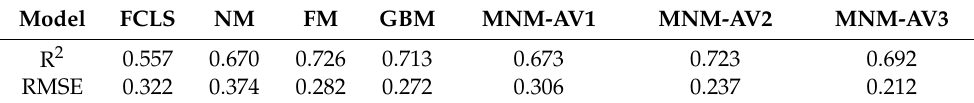
Table 4. Assessment of lichens abundance estimates derived with different models.